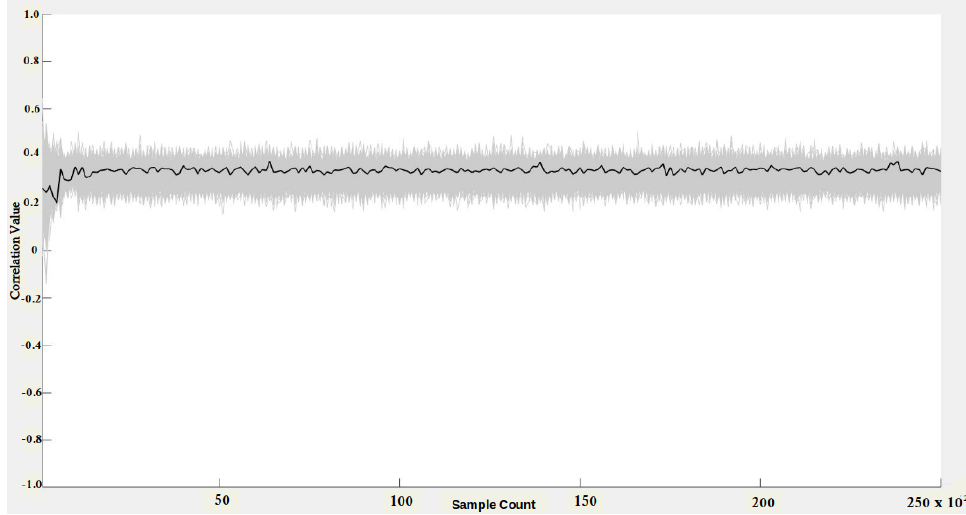
Figure 9. CPA attack on Montgomery multiplier.